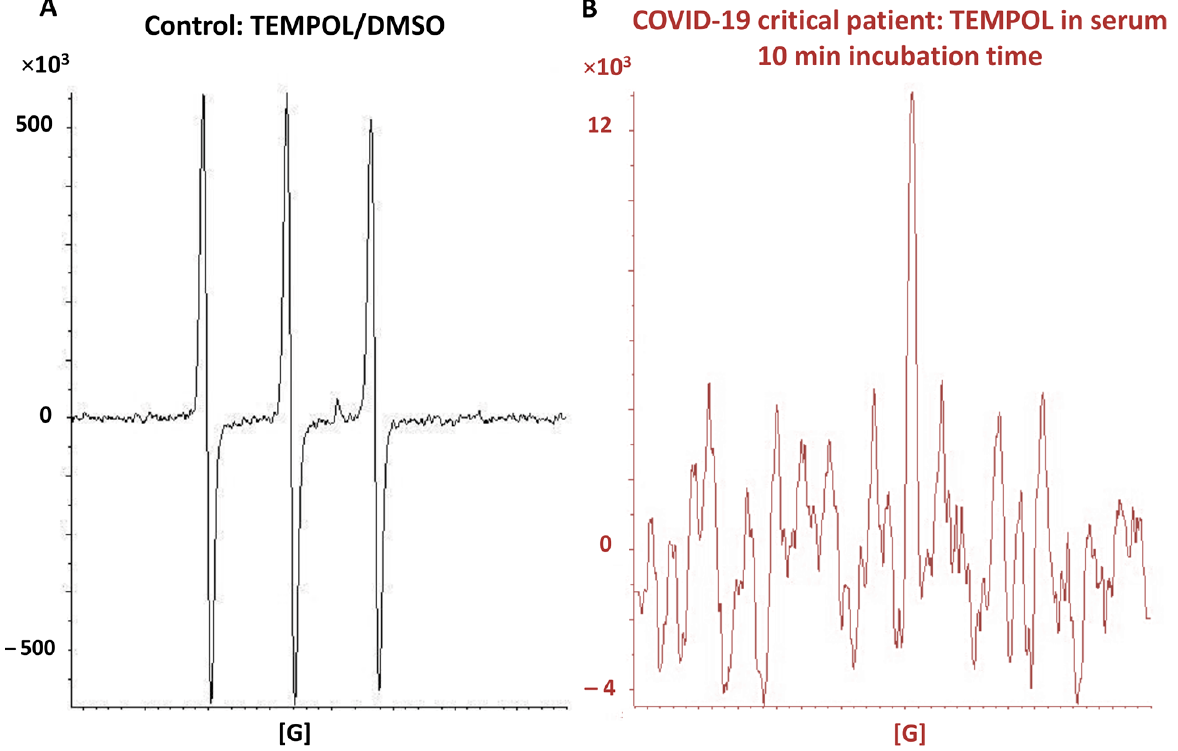
Figure 4. ( A ) EPR spectra of TEMPOL/DMSO and ( B ) EPR spectra of a TEMPOL-treated severe COVID-19 patient at the 10th min.